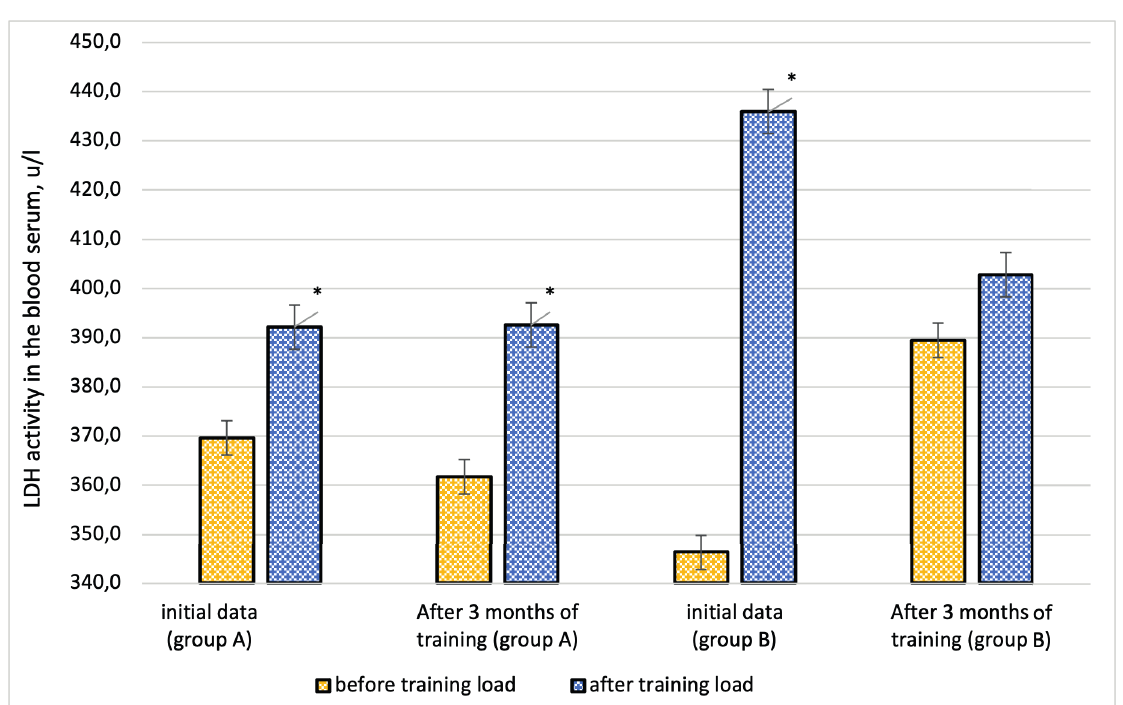
Fig. 1. Change in LDH activity in the blood serum of group A and B female athletes during the research, n = 36. Note: * - p <0.05, compared to the indicators before training load.